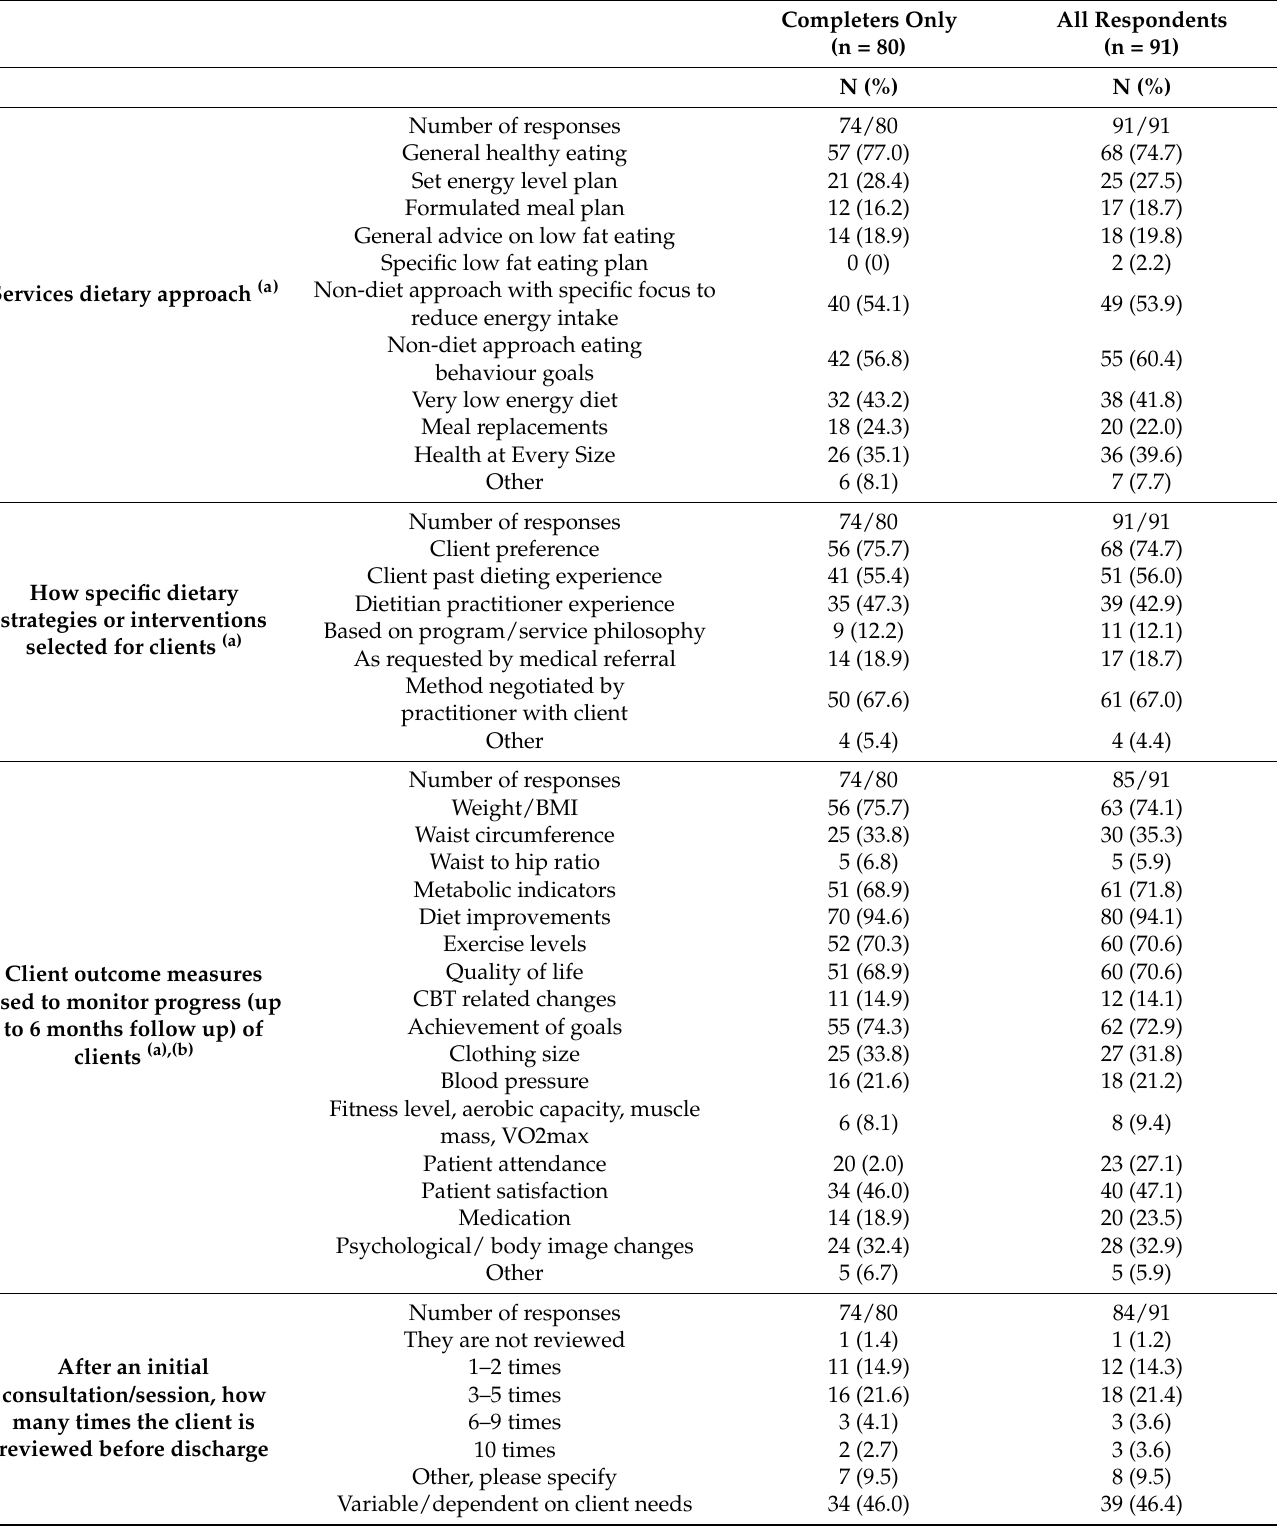
Table 2. Dietary strategies and monitoring of outcomes used by